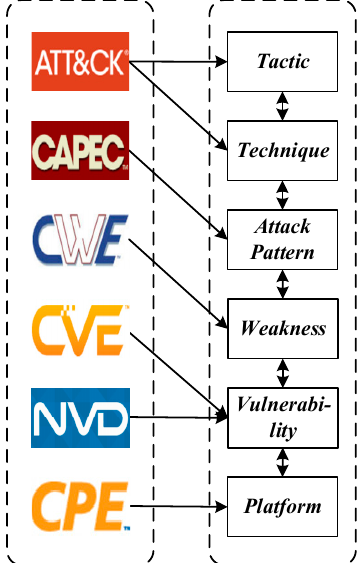
Figure 1. Schematic of relational mapping